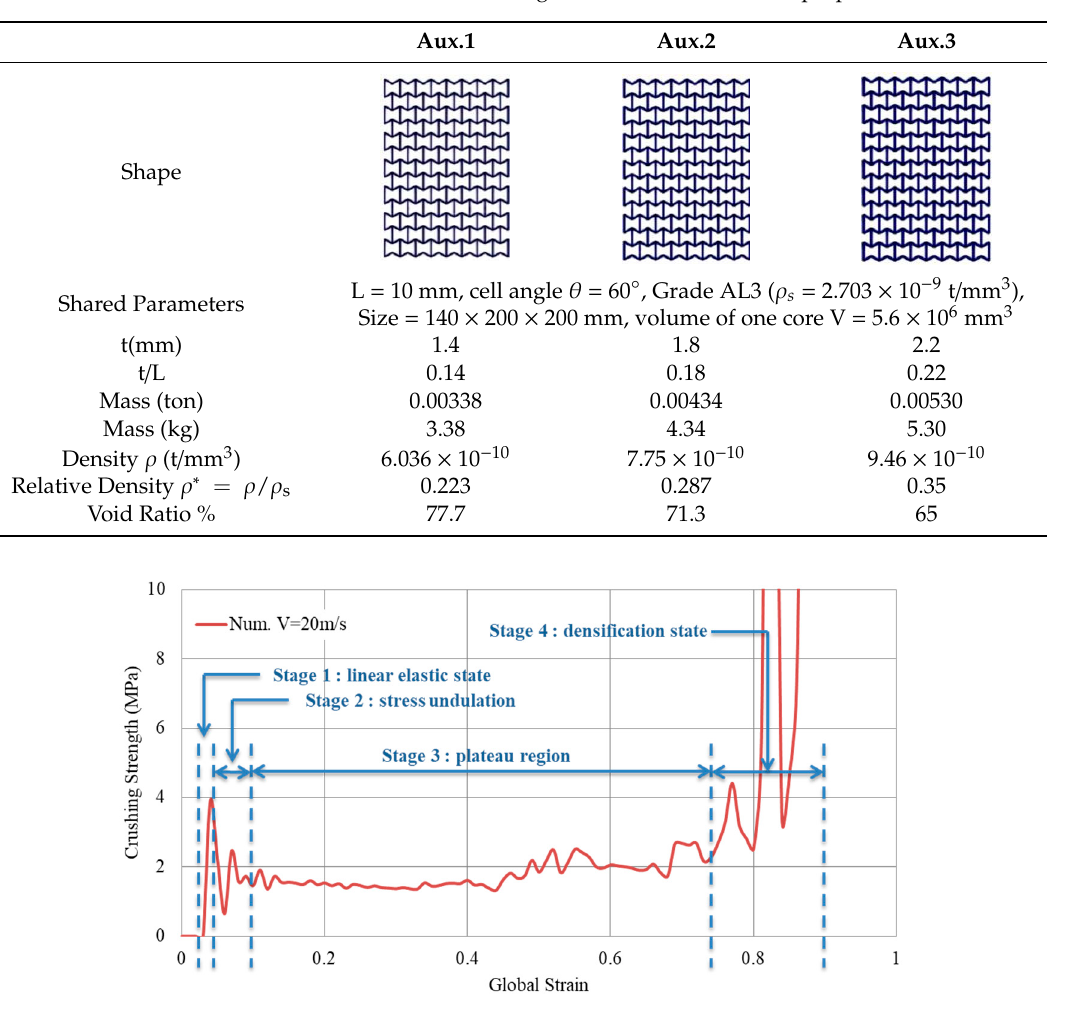
Table 7. The three auxetic cores with their geometric and mechanical properties.